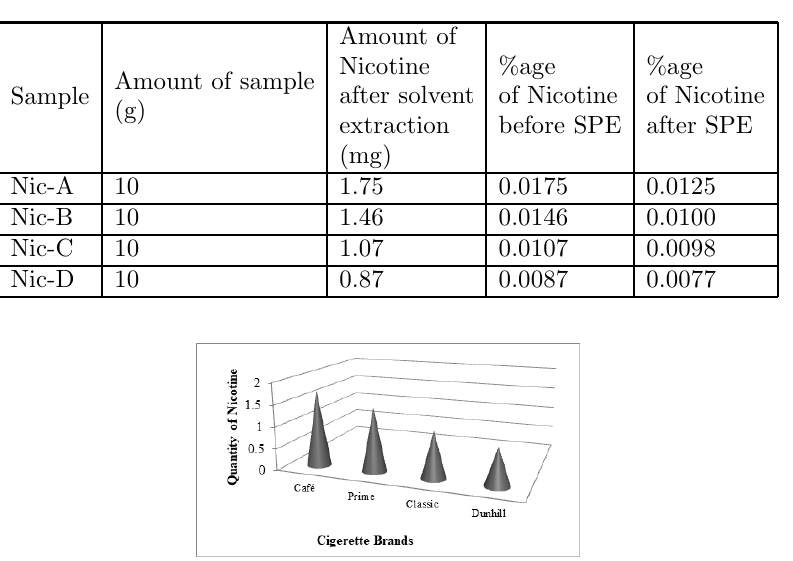
Table 4. The weight of Nicotine in four different brands of cigarettes